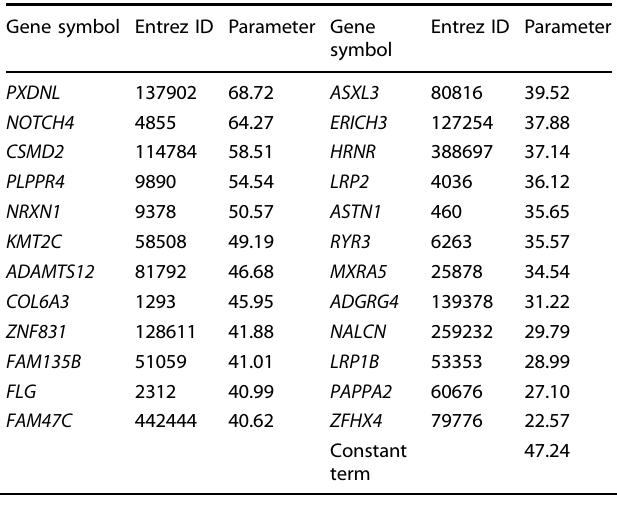
Table 1. Genes and the corresponding parameters used in